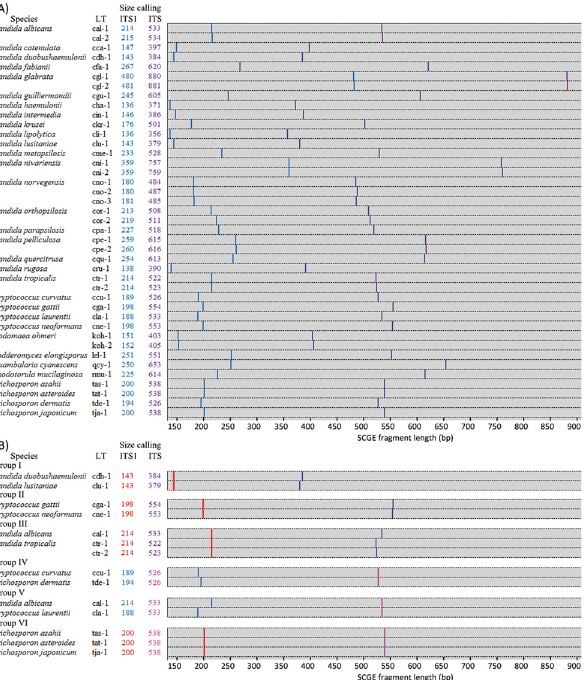
Fig 2. SCGE ITS length types (LTs) database established in the present study, including amplicon lengths (bp) of the ITS1 and ITS regions called by SCGE for each LT, and an in silico gel-view diagram. The amplicon sizes has been rounded up to the nearest whole number. Fig 2A, the whole database. Fig 2B, LTs of different species that had the same-length ITS1 or ITS region amplicons. In Fig 2A and 2B, gel-bands in blue or red represent amplicon of the ITS1 region, while gel-bands in purple or pink represent amplicon of the ITS region. Gel-bands in red or pink indicated the length of ITS1 or ITS amplicons were shared by different